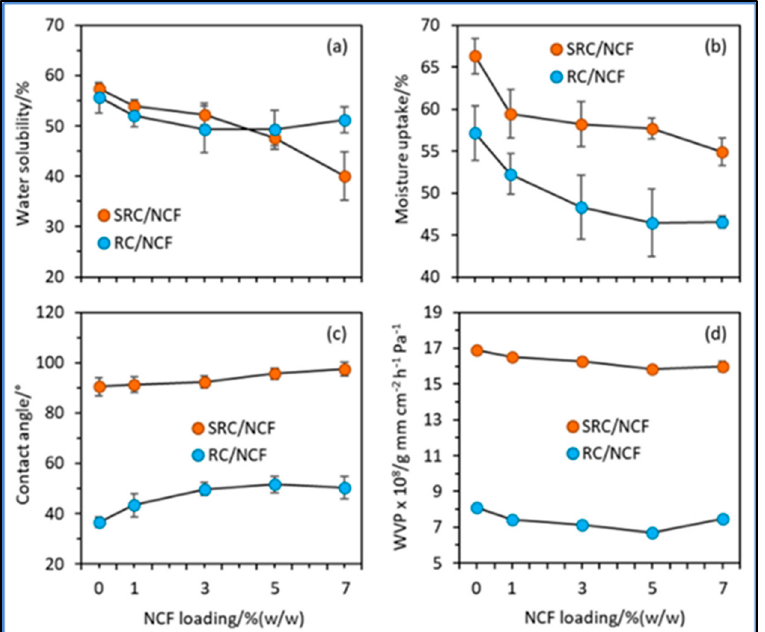
Figure 4. Plots of ( a ) water solubility, ( b ) moisture uptake, ( c ) contact angle, and ( d ) water vapour permeability (WVP) against the NCF loading for the SRC/NCF and RC/NCF fi lm formulations permeability (WVP) against the NCF loading for the SRC/NCF and RC/NCF film (taken from [51], MDPI CC BY).